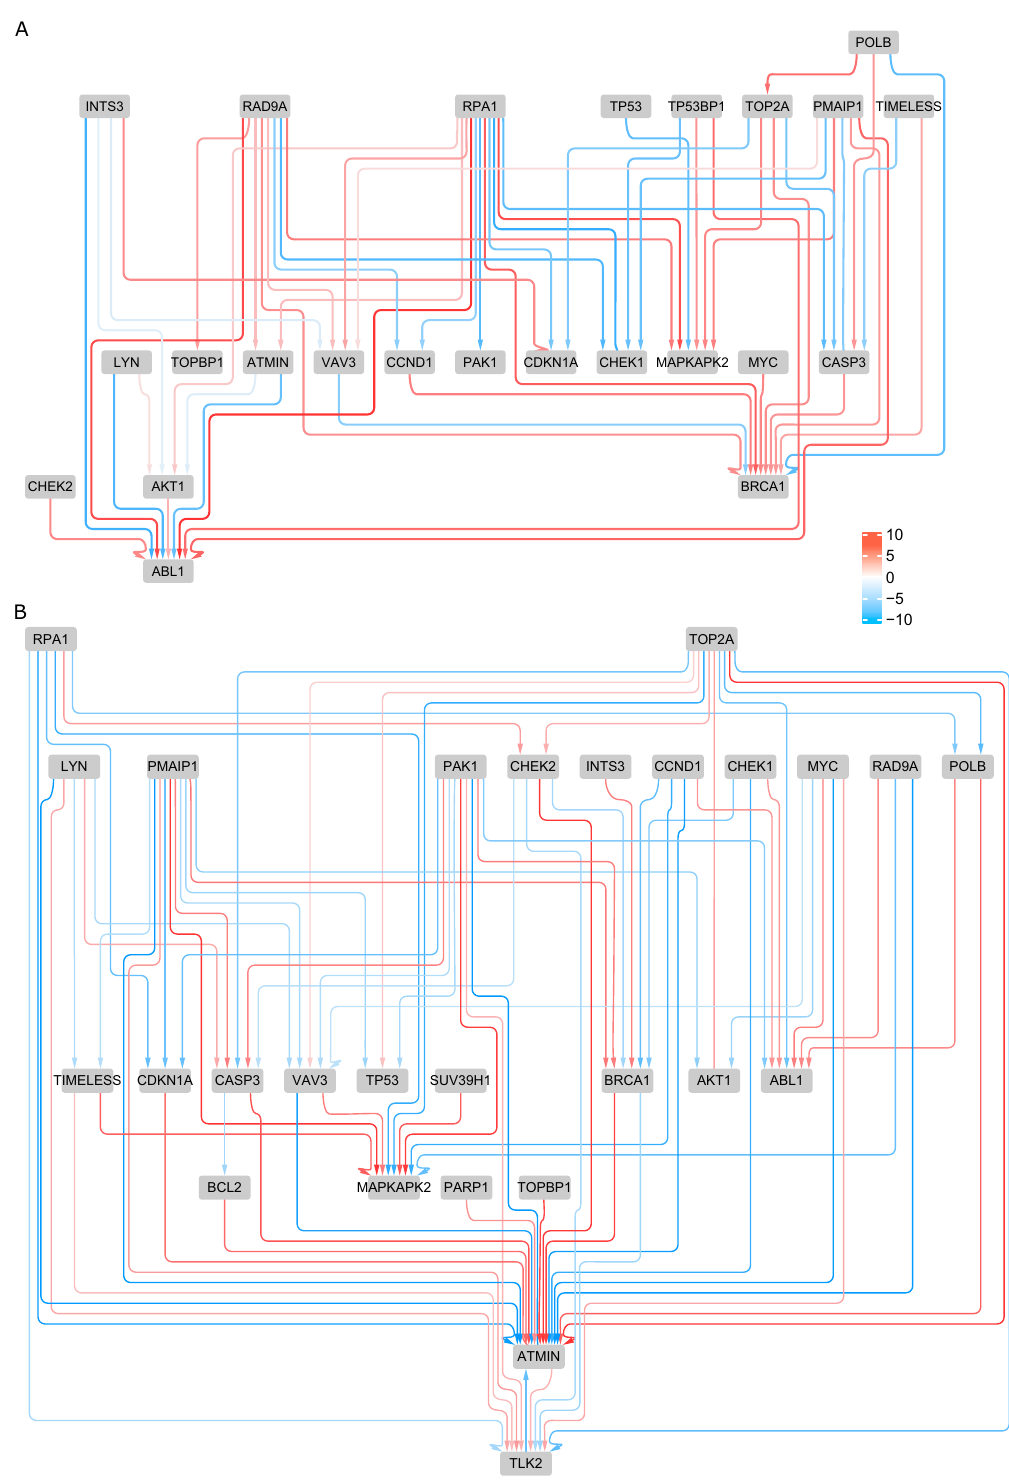
Fig 5. Networks inferred with MRA+CLR (top 10% selection). Genes involved in cellular response to DNA damage stimulus (GO:0006974) in (A) normal kidney cells, and (B) melanoma cells ( B ).